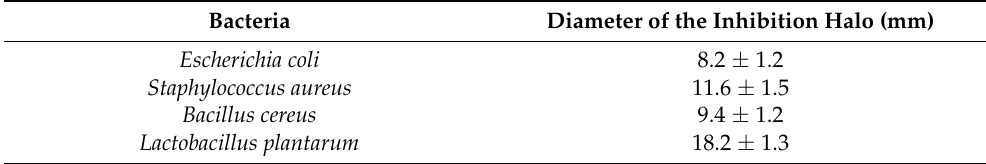
Table 4. Antibacterial activity of essential oil from Crithmum maritimum L. by the disc diffusion method. Results are expressed as mean ± SD.